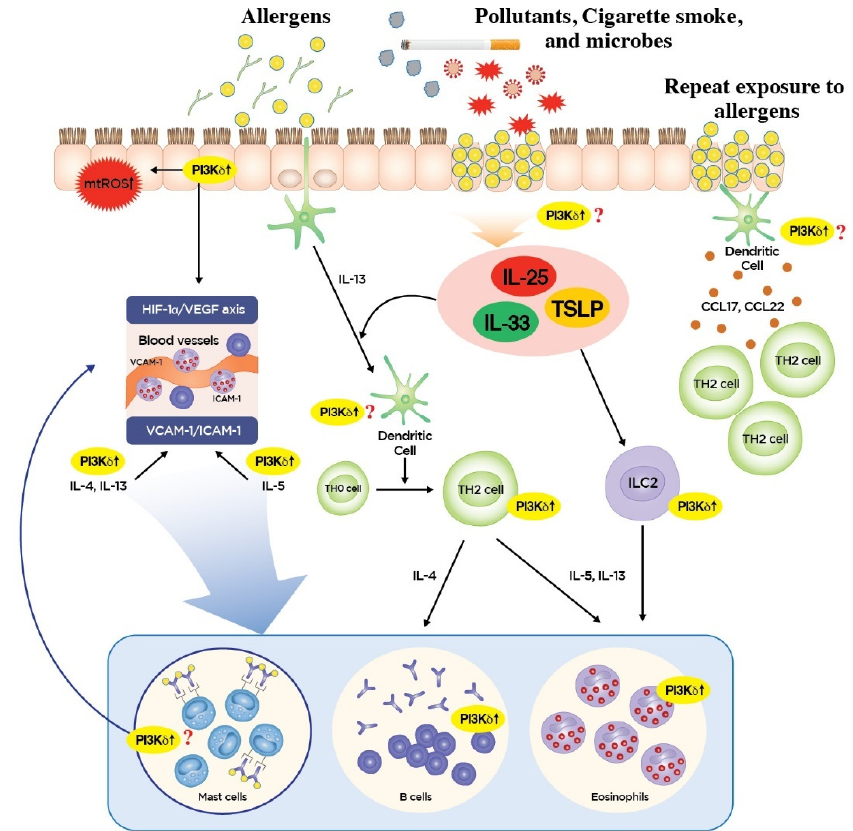
Figure 1. Roles of phosphoinositide 3-kinase- δ (PI3K- δ ) in type 2 inflammation of bronchial asthma. PI3K- δ may contribute to various aspects of allergic and non-allergic eosinophilic airway inflammation